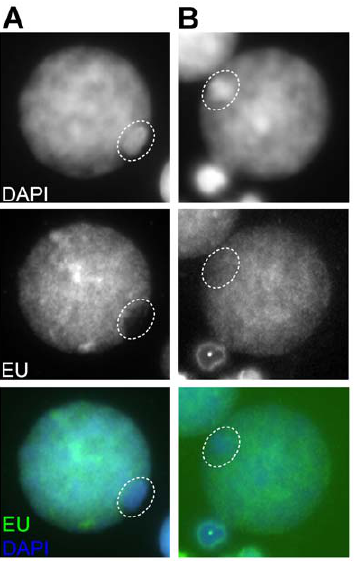
Figure 6. Variation in transcriptional activity of the XY body determined by EU incorporation. The DAPI intense XY body is indicated by an oval in both late pachytene nuclei. A Low RNA expression at the XY body. B High RNA expression at the XY